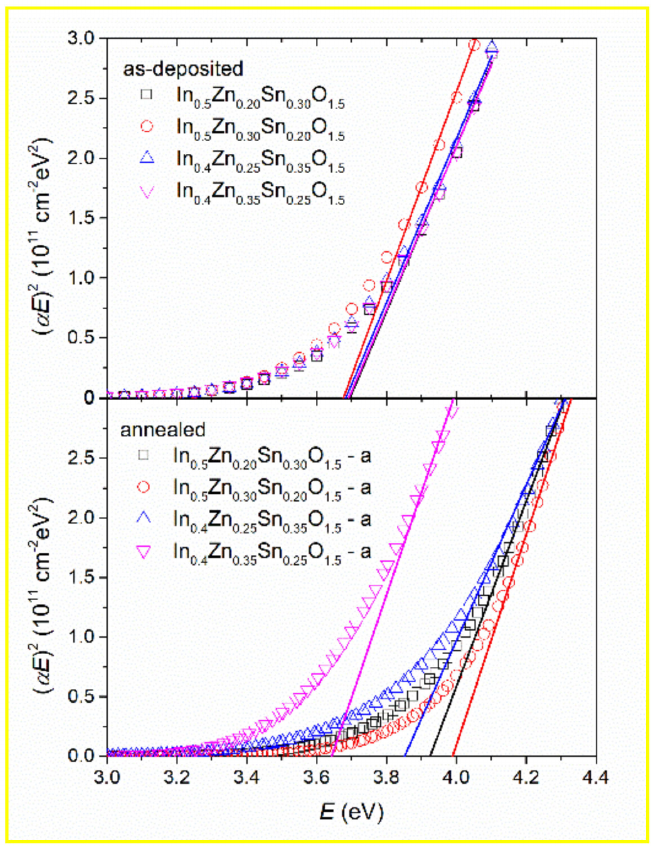
Figure 4. ( α E ) 2 as a function of photon energy (symbols) for as-deposited and annealed non- stoichiometric IZTO samples obtained by using the parameterized semiconductor oscillator function (PSEMI) oscillator and its linear part described by Tauc model (solid